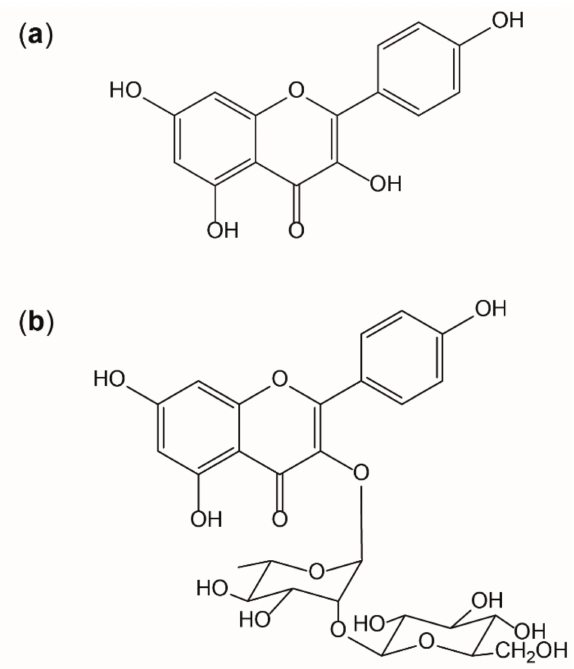
Figure 8. Structure of kaempferol ( a ) and the glycoside kaempferol 3- O - β -D-glucopyranosyl (1 → 2)- α -L-rhamnopyranoside ( b ).